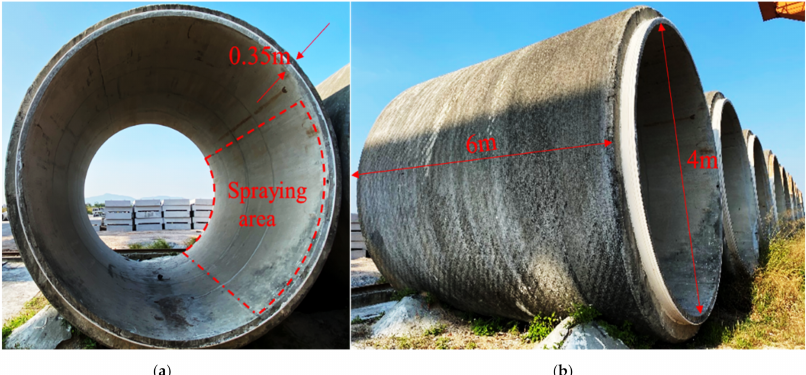
Figure 1. Spraying test model: ( a ) cross section; ( b ) vertical